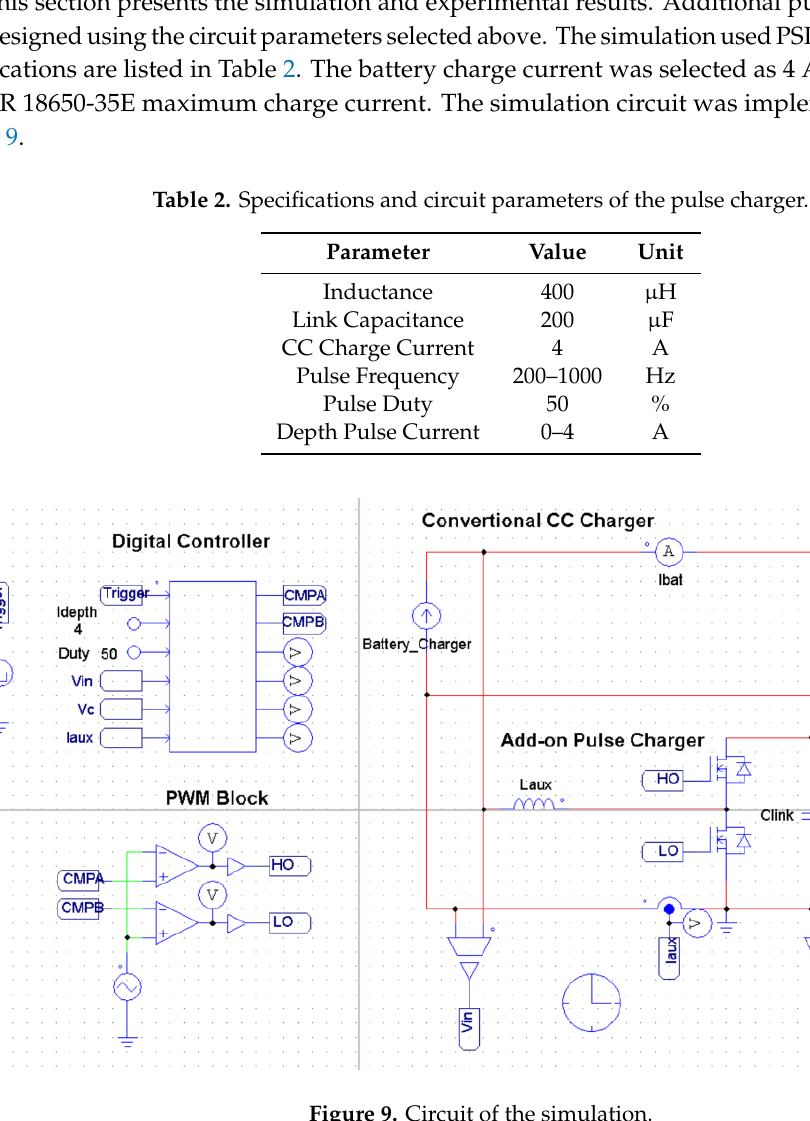
Figure 10. Results of the simulation at a 50% pulse duty ratio and 500 Hz pulse frequency.